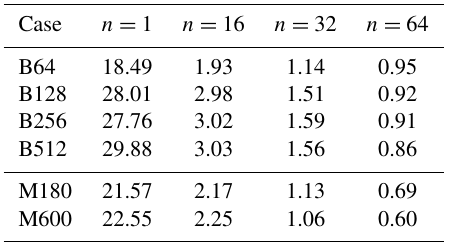
Table 1. Speedup of GPU simulation compared to respective CPU simulation performed on n